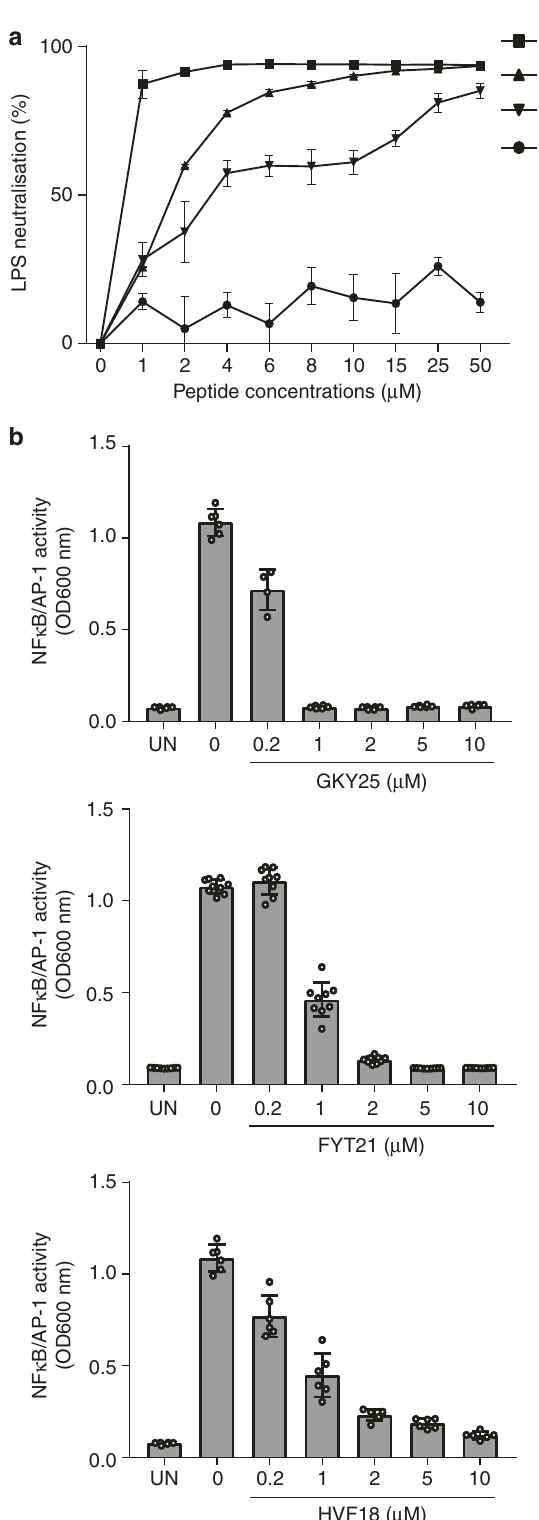
Fig. 2 Thrombin C-terminal peptides bind and inhibit LPS-induced proin fl ammatory responses. a Limulus amebocyte lysate (LAL) chromogenic assay showing variations in TCPs ability to neutralise E. coli LPS in solution. Results are means ± SD of two experiments. b Inhibition of NF-kB activation in THP-1 monocytes stimulated with 10 ng ml − 1 E. coli LPS upon treatment with indicated TCPs at the speci fi ed concentrations, 20 h post stimulation. Results are means ± SD of at least six